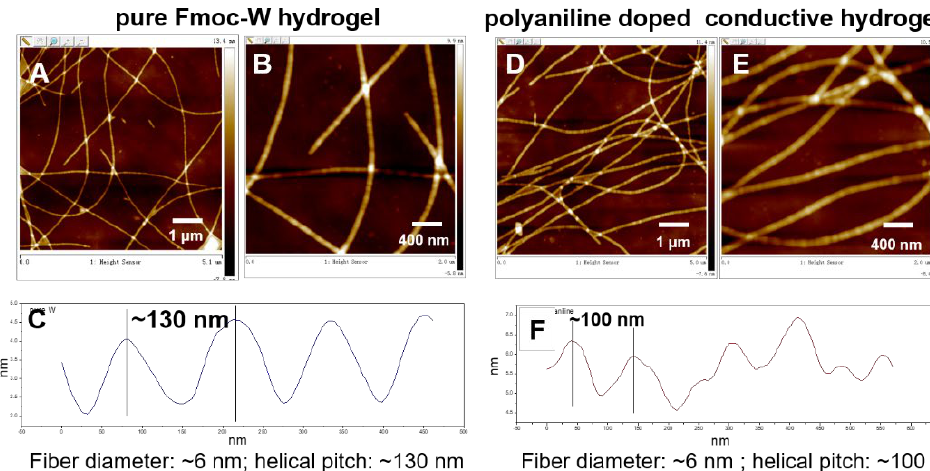
Figure 2. AFM images ( A , B ) and helical pitch ( C ) of pure Fmoc-W hydrogel; AFM images ( D , E ) and helical pitch ( F ) of polyaniline doped conductive hydrogel.